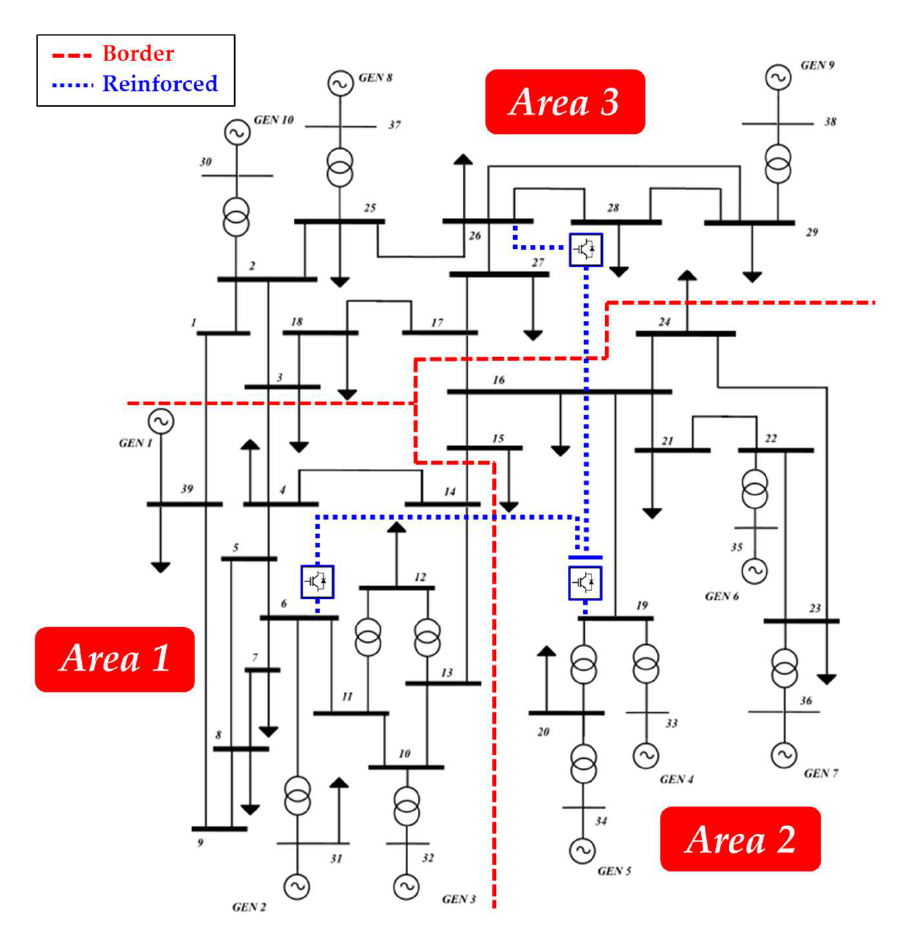
Figure 4. Modified IEEE 39 bus test system.